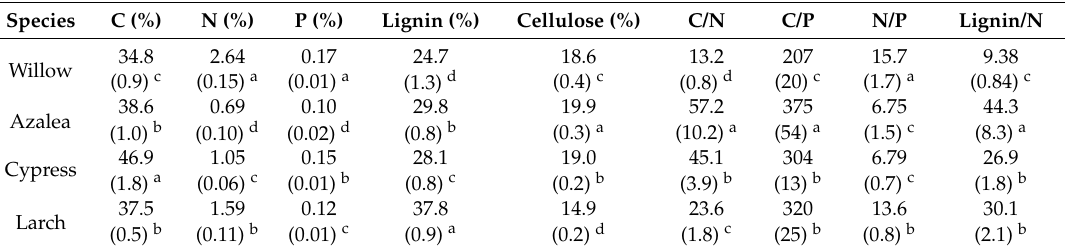
Table 2. Initial chemical traits of willow, azalea, cypress, and larch foliar litters.